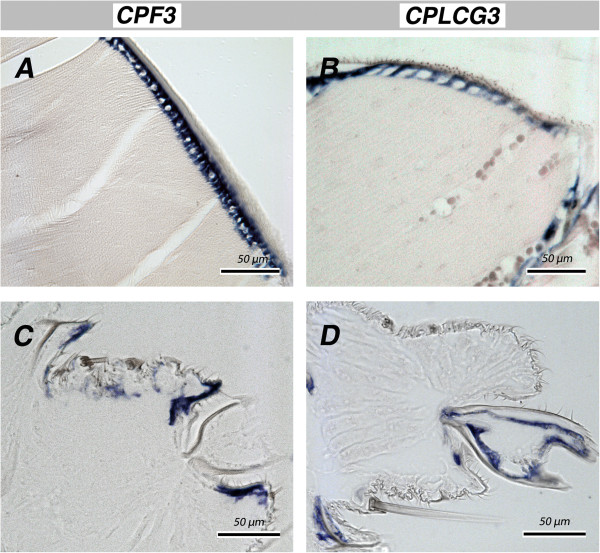
In situ hybridization to other regions. Hybridization to muscle insertion zones for both CPF3(A) and CPLCG3(B). (A) maleP24, (B) female P24 (C, D) Hybridization to genitalia, (C) adult female 12 hr, (D) male P24.